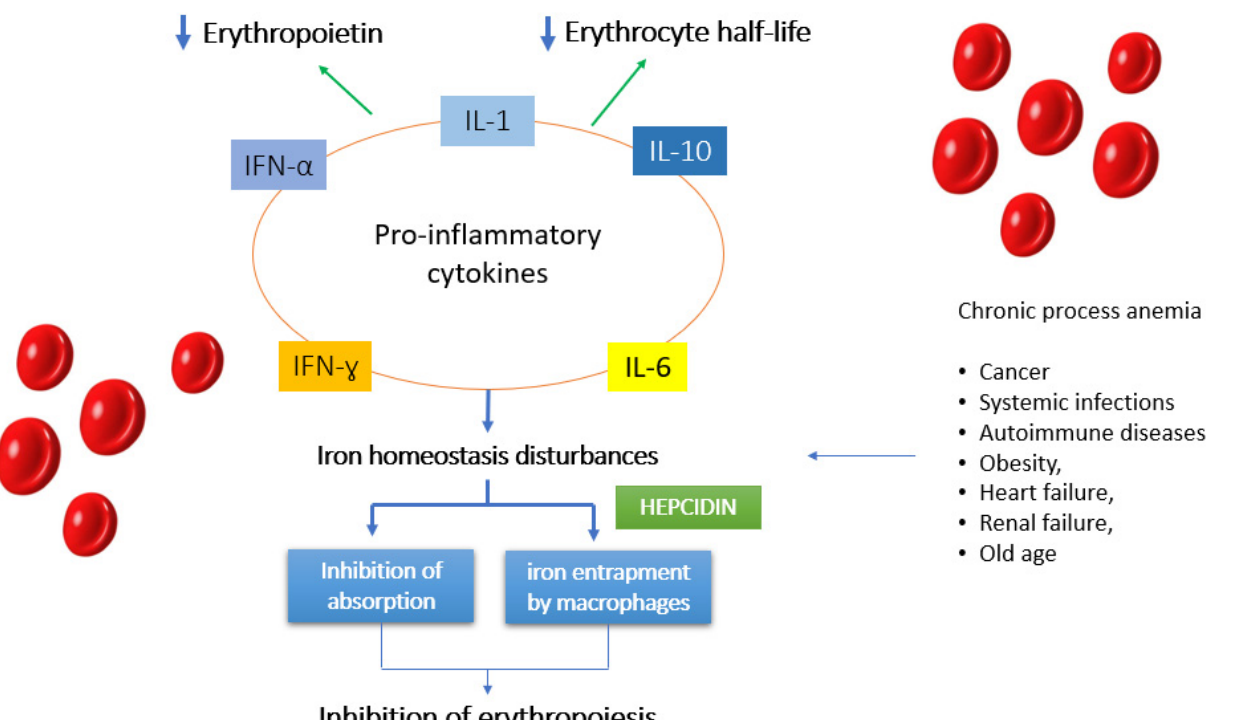
Figure 3. In CD there is a component of systemic inflammation which in some cases may also contribute to the pathogenesis of anaemia. This contribution is less than that due to malabsorption. The figure illustrates some mechanisms involved in the pathogenesis of anemia of chronic disease.